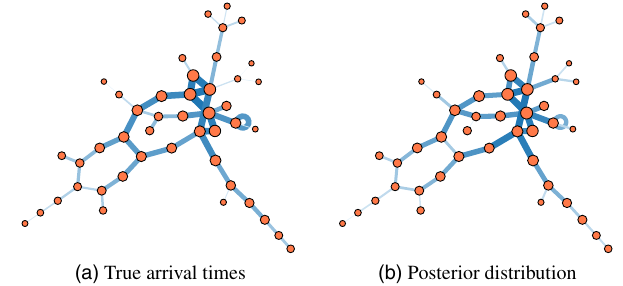
FIG. 1. Reconstructing the history of a growing